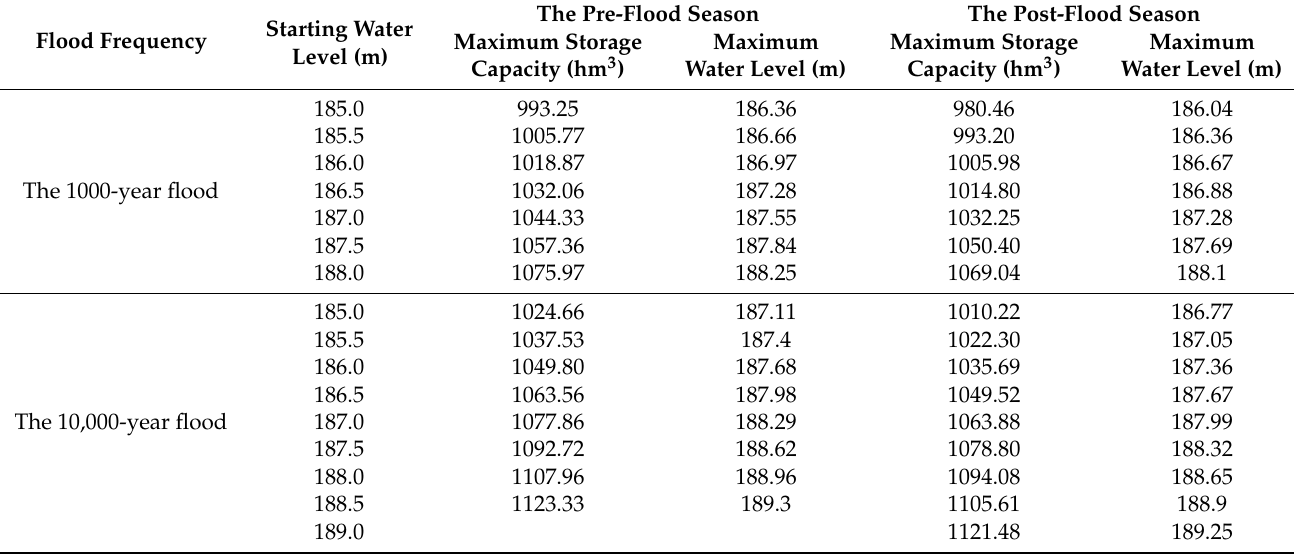
Table 7. Operation result of each frequency and start counting water level.